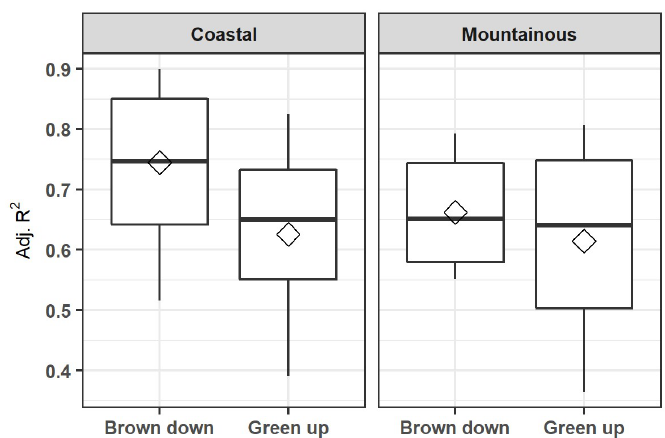
Figure 11. Adjusted R 2 from single site model for LFM estimation using accumulative SM and CGDD. All models have a p-value < 0.05. The average adjusted R 2 across the 12 sites are marked as a diamond in the boxplot. Coastal and mountainous sites are plotted in different panels.